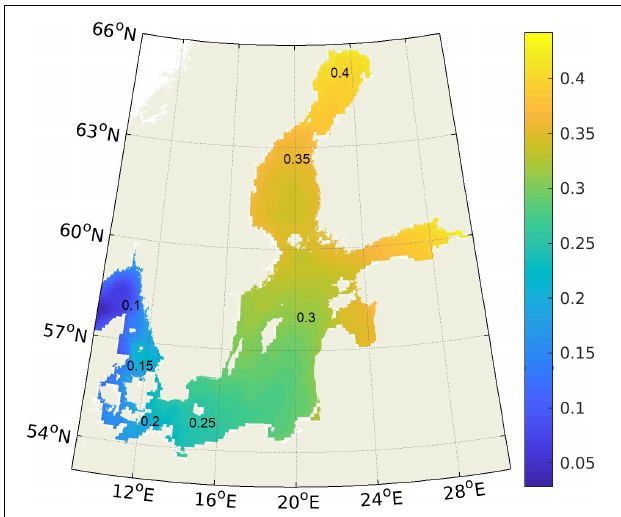
FIGURE 3 | Mean sea level (meters) in the Baltic Sea 1990–2009 from the HBM ocean model reanalysis.